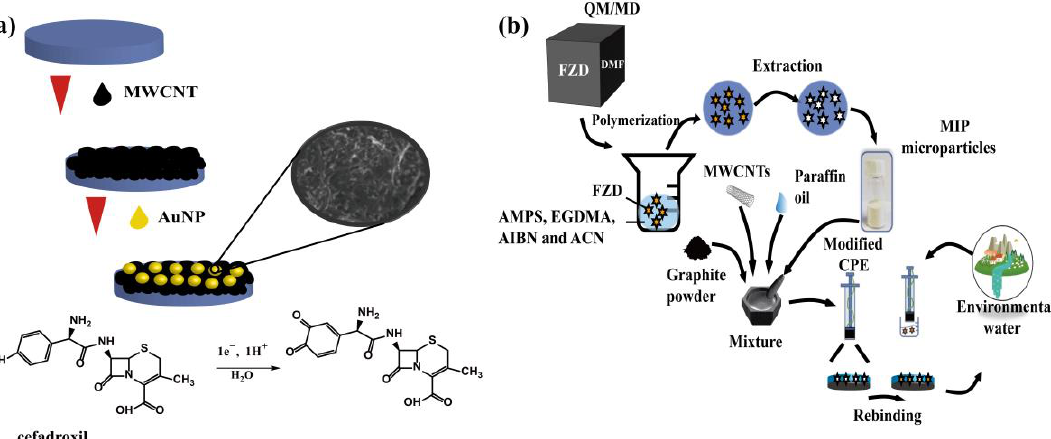
Figure 3. ( a ) The determination of cefadroxil β -lactam antibiotic was carried out using a modified gold nanoparticle/multiwalled glassy carbon nanotube [34]. ( b ) Molecularly imprinted carbon paste electrode for furazolidone detection [35].